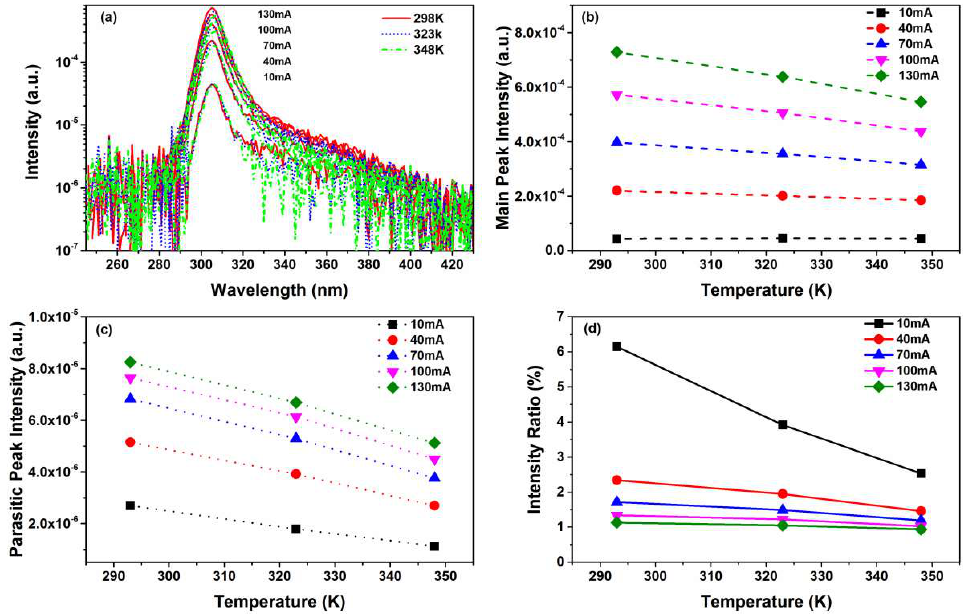
Figure 3. EL spectral data recorded at various forward currents and temperatures of 298, 323, and 348 K. ( a ) Spectral distributions, ( b ) main peak intensities, ( c ) parasitic peak intensities, and ( d ) peak intensity ratios.